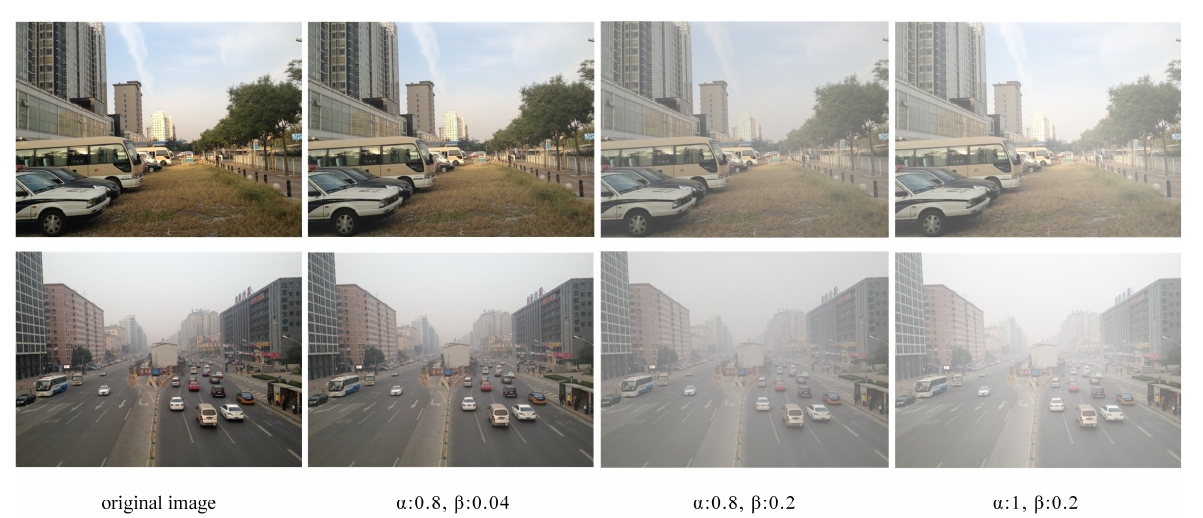
Figure 4. An example of the RESIDE dataset.